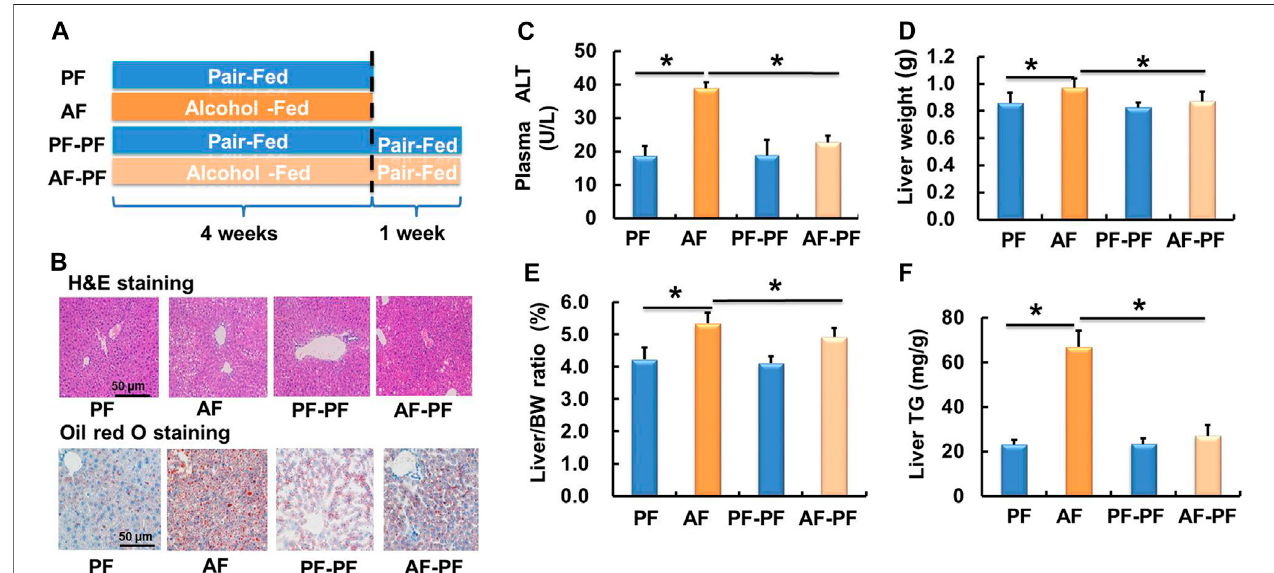
FIGURE1| Alcoholwithdrawalamelioratesalcohol-inducedhepatic steatosisandliverinjury. (A) Schematicdiagramoftheresearchdesign. (B) H&Estainingand oil red O staining photomicrographs of the liver section (magni fi cation, 100x). (C) Plasma alanine aminotransferase (ALT) level. (D) Live weight. (E) Liver weight/body weight ratio. (F) Triglyceride (TG) content in the liver. * p < 0.05 indicates statistically signi fi cant differences ( n (cid:1) 8).